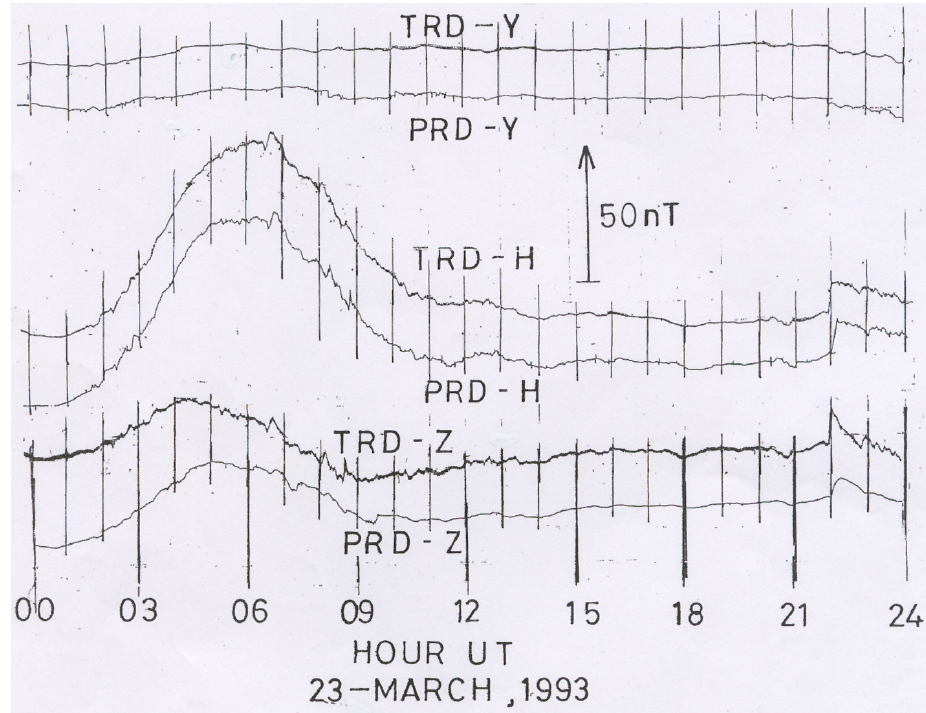
Fig. 3. Comparisons of the magnetograms at Peredinia (PRD) constructed from the digital data and the magnetogram at Trivandrum (TRD) from the ISMIRAN IV magnetometer for 2–3 March